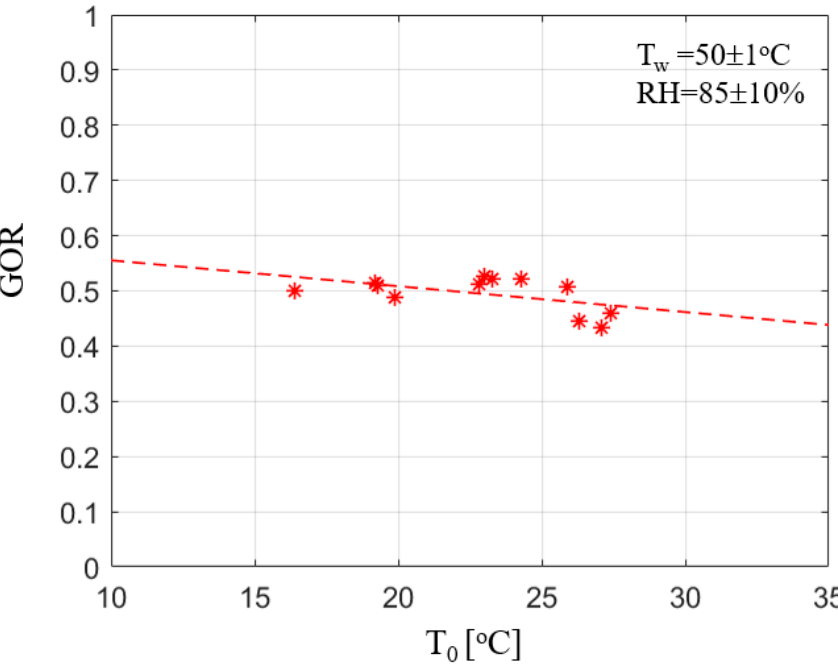
Figure 11. E ff ect of ambient temperature T 0 on GOR Figure 11. Effect of ambient temperature T 0 on GOR .